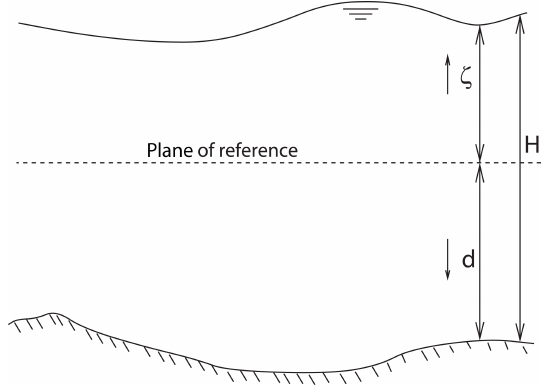
Figure 1. Definition of the free-surface level ζ and the bottom level d (Zijlema and Stelling,